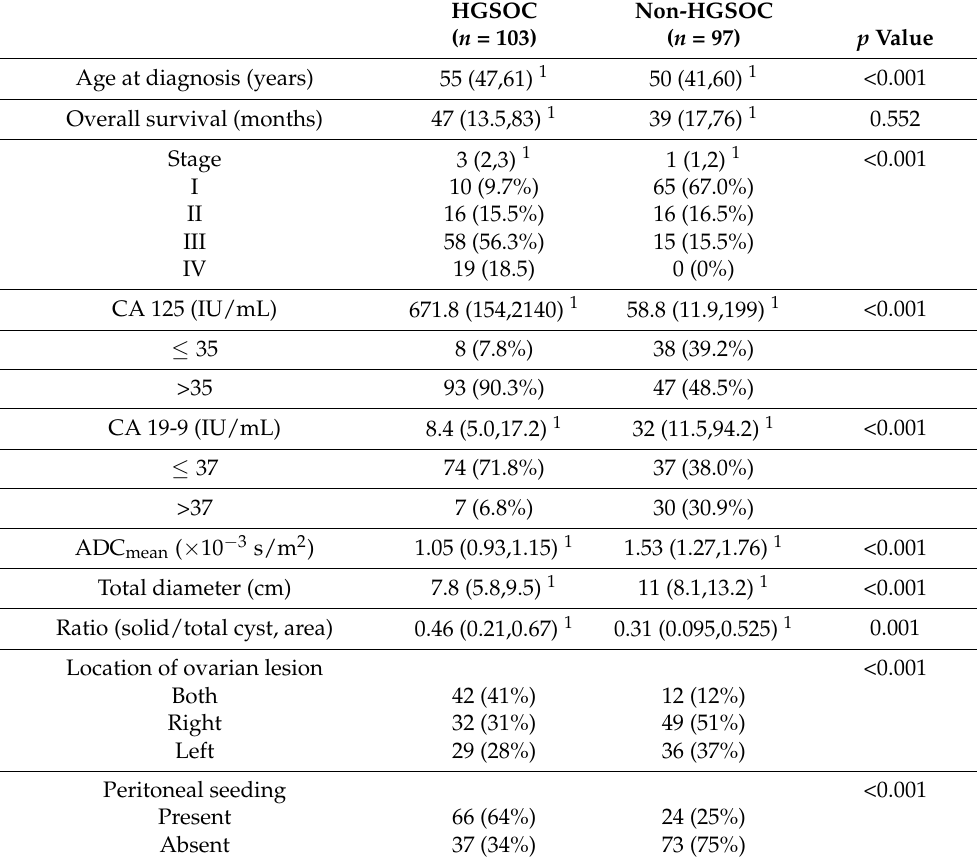
Table 1. Characteristics of the study population ( n =